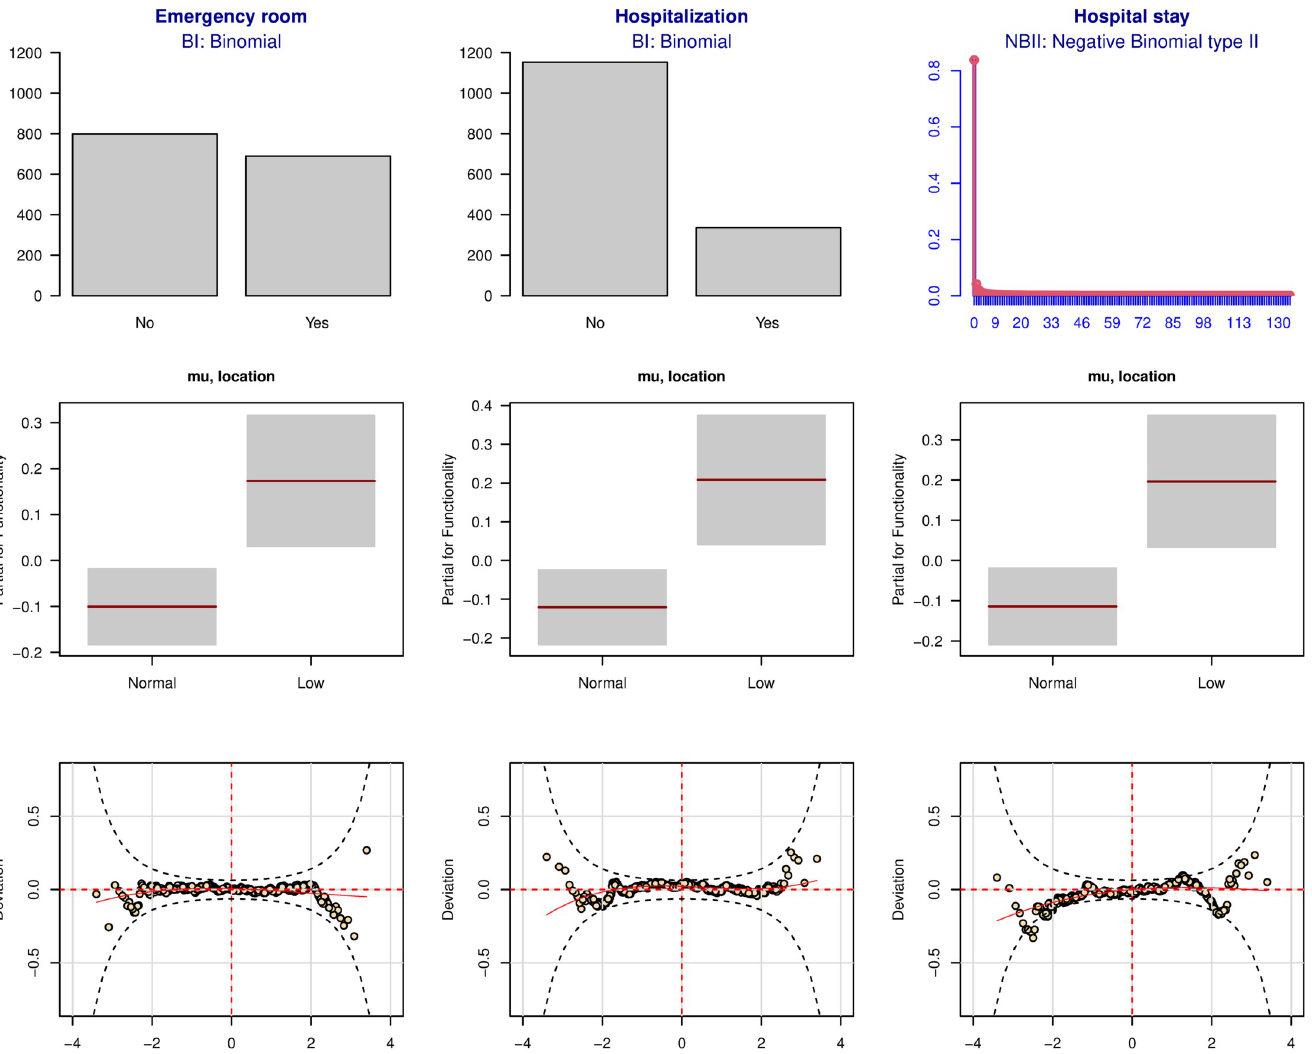
Fig 2. Goodness of fit of the models related to emergency room and hospital care. The first row of figures shows the histograms of the observed data (in gray) where the selected distribution is adjusted (in red) for each service; second row, the partial effect of functionality in each model; and the third row, the worm-plots of the models (the more horizontal the red line, the better the model fits the